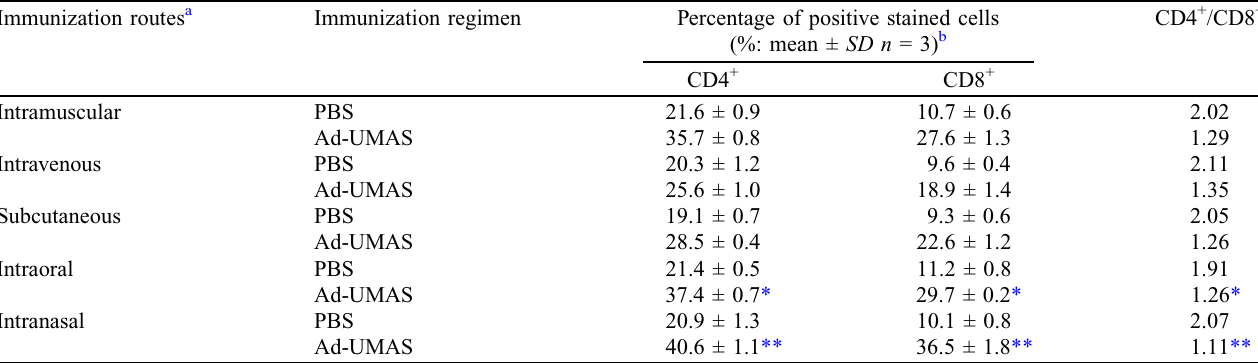
Table 2. CD4 + and CD8 + subtypes of T-cells from immunized mice measured using flow